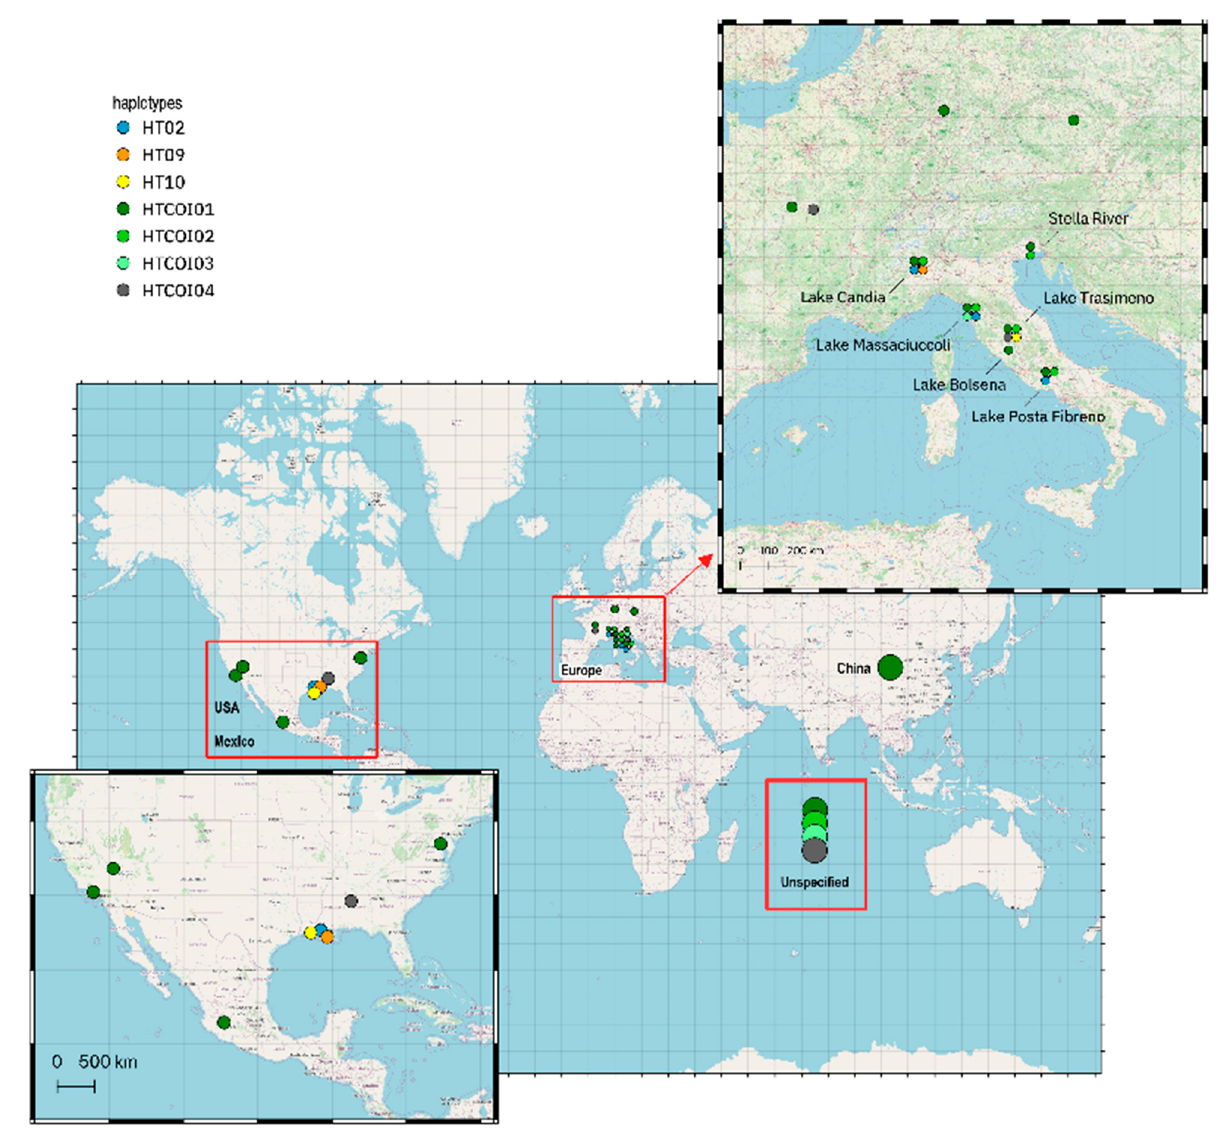
Figure 6. Geographic distribution of mtDNA haplotypes (mitochondrial control region and COI) from this study observed in other countries. Further details are reported in Tables S1 and S3.